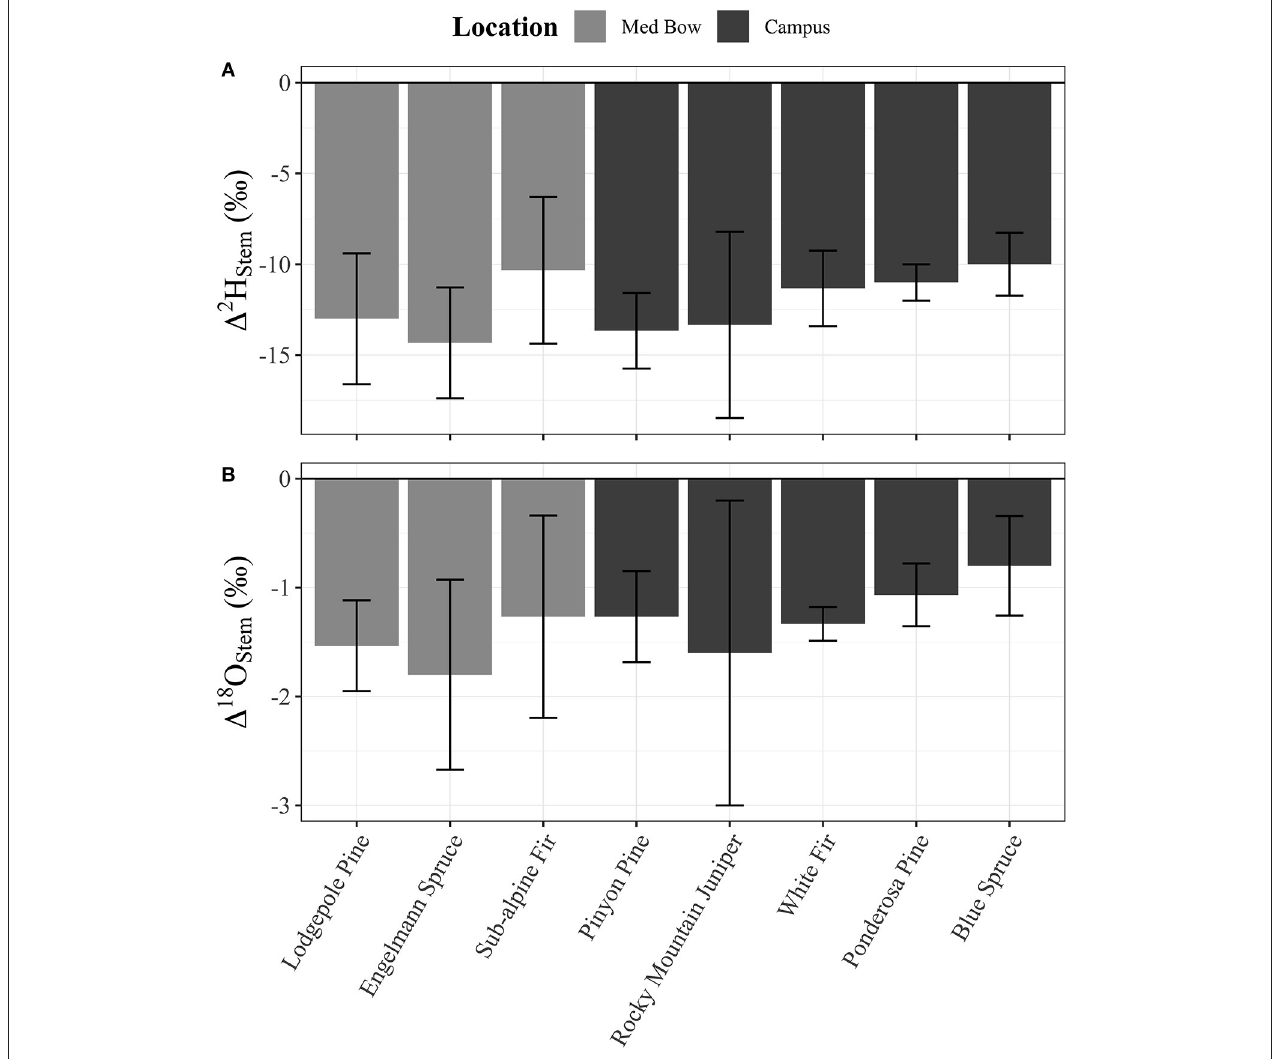
FIGURE 5 | (A) 1 2 H stem and (B) 1 18 O stem column plots for each species with n = 3 per species. Plot panels share the same x -axis and legend.